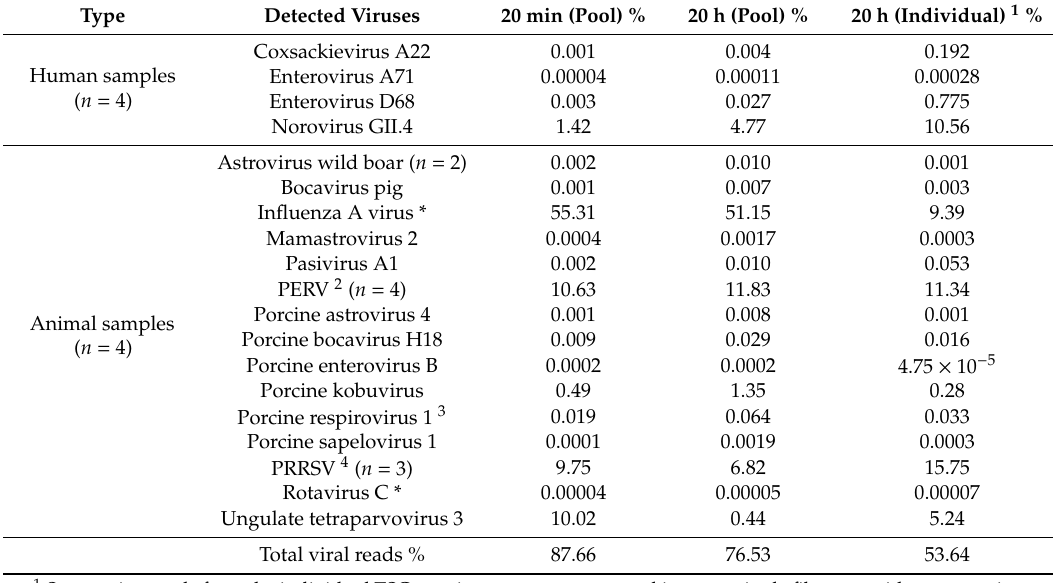
20 min and 20 h pools (Table 2). Sequence reads were mapped against an in-house viral database on CLC and normalized. Table 2. Sensitivity of detected viruses in pooled (20 min and 20 h hybridization) and individual targeted sequence capture (TSC) reactions. Sequencing reads were normalized against the total number of